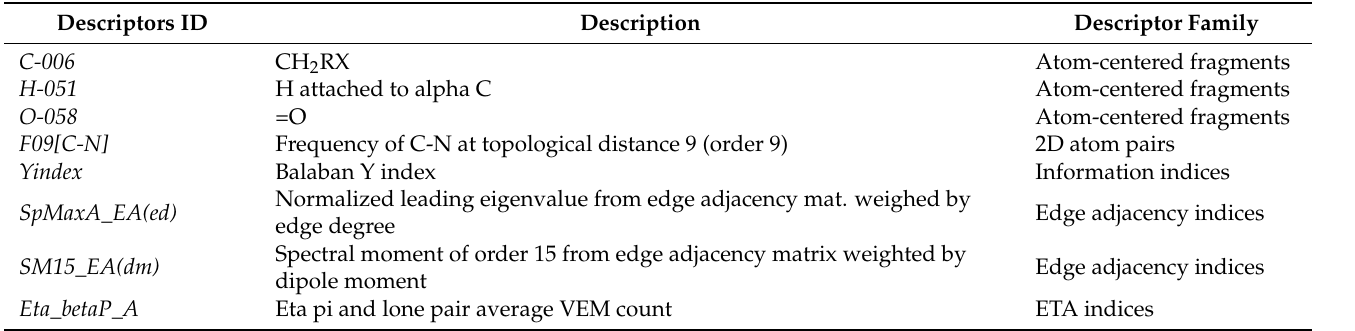
Table 3. Molecular descriptors included in the four AChE